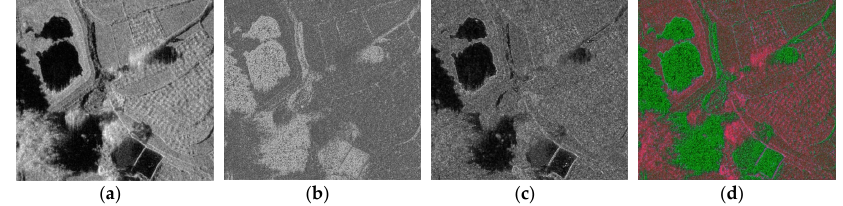
Figure 9. The Gray-Level Gradient Co-occurrence Matrix (GLGCM) results. ( a ) the gray-mean result. ( b ) the gradient mean result. ( c ) the gray mean square error. ( d ) the concatenation results of GLGCM.